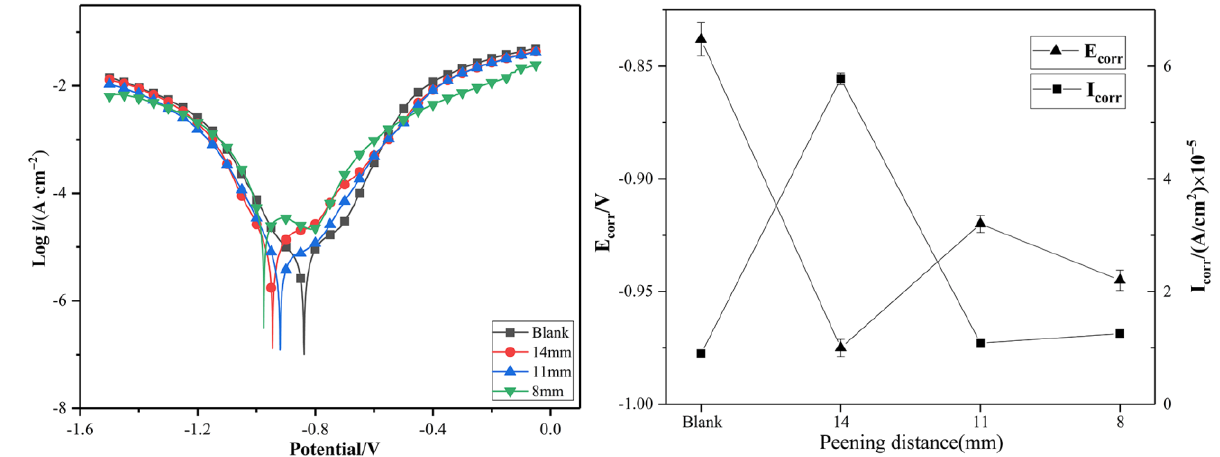
Table 7. The parameters of the equivalent elements in the equivalent circuit of the samples with different USP distances.